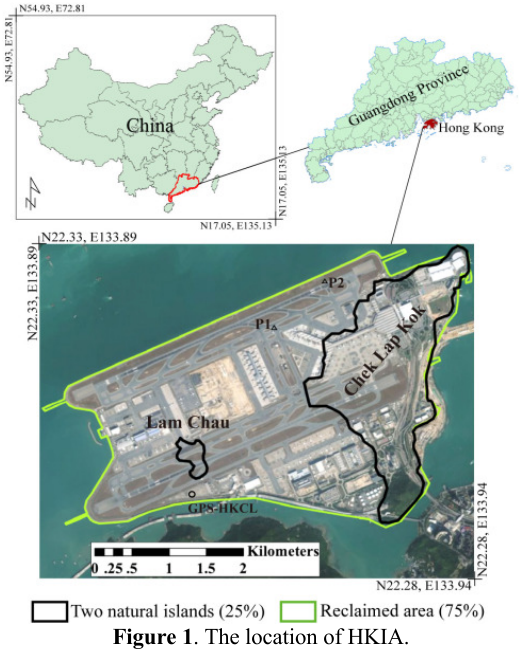
Figure 1 . The location of HKIA.